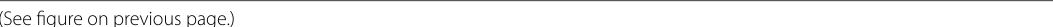
figure on previous page.) Fig. 21 a Molecular structures of the emitters and strategical relationships. b PEluminance-EQE curves. c J–V and luminescence curves and normalized EL spectra of d PTZ-TTR (inset: CIE variations from 100 to 1000 cd/m 2 ) and e PTZ-Ph-TTR (inset: CIE variations at different voltage) (Reproduced with permission from Ref. [52] Copyright © 2018, American Chemical